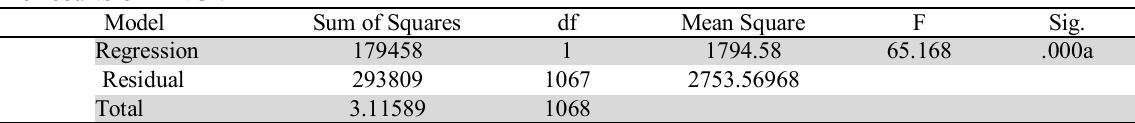
The results of ANOVA